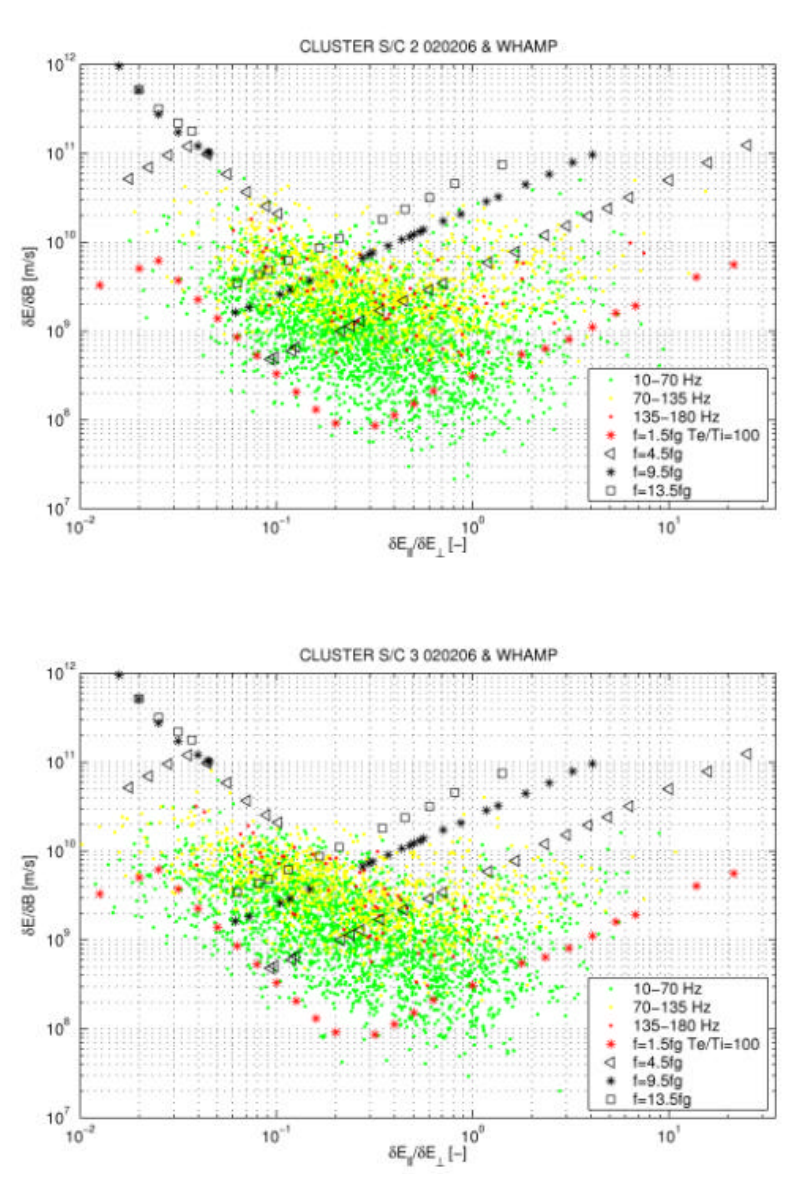
Fig. 8. An analysis of all 0.1-s sub-intervals from the 2-min of Cluster spacecraft 2 data in Fig. 1 is shown in the upper panel, see the text for details. A similar analysis for the two minutes of spacecraft 3 data in Fig. 2 is shown in the lower panel. Different colours correspond to different frequency ranges. Also shown are theoretically obtained δ E/ δ B ratios for different frequencies, see the text for details (1.5f + about 10Hz). The observed emissions are consistent with a mixture of linear wave